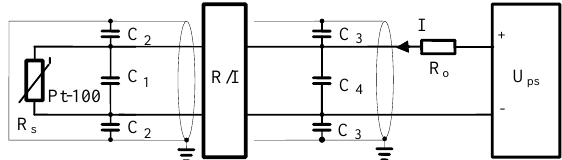
Figure 10. Equivalent electrical diagram of the temperature measurement line, where: R s —resistance of Pt-100 sensor, R / I—transmitter 4–20 mA, R o —equivalent resistance of all resistances in the 4–20 mA current loop I, C 1,2,3,4 —equivalent capacities of Pt-100 sensor and connecting cables, U ps —source of DC voltage.